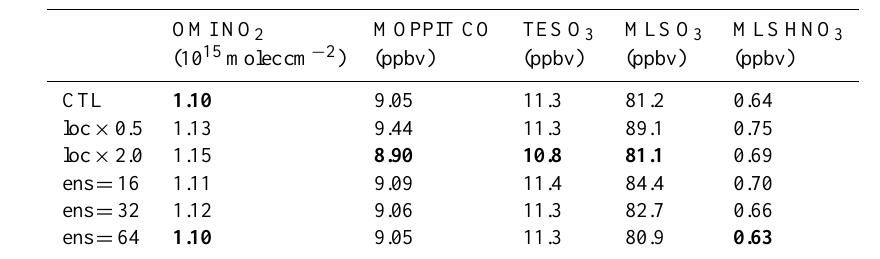
Fig. 3. Correlations between species in the background error covariance matrix, estimated from the LETKF ensemble at 950hPa (left) and 500hPa (right) averaged over 15–20 July 2007. The global mean of the covariance estimated for each grid point is plotted. The matrix includes concentrations of all the predicted species, surface NO x emission (NO x -emi.), surface CO emissions (CO-emi.), and lightning NO x sources (LNO x ). O x is the sum of O 3 and O ( 1 D ) , and NO x is the sum of NO, NO 2 , and NO 3 . The red (blue) colour represents positive (negative) correlations. Table 4. The performance of the data assimilation for different parameters: the horizontal localization length (loc) and the ensemble number (ens). Ten-day mean (averaged over 20–30 January 2007) global mean RMS innovation of the OmF for each assimilated data are shown. The control (CTL) simulation was conducted with loc = 450km for NO x emissions and with 600km for CO emissions, lightning NO x , and the concentrations, and ens = 48. The simulations with different loc values were conducted with ens = 48. The smallest RMS innovation for each comparison is shown in